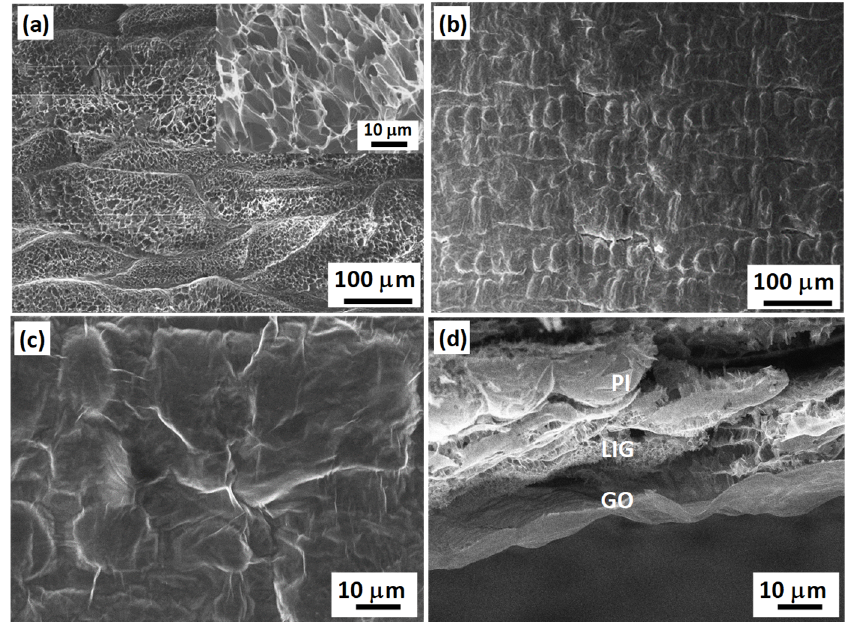
Figure 1. SEM images of ( a ) the as-fabricated LIG electrode. Inset: high magnification image of LIG; ( b ) low magnification image of the GO film deposited on the LIG electrode; ( c ) high magnification image of GO on LIG; ( d ) cross-section image showing the GO layer deposited on the LIG electrode, as well as the residual unconverted polyimide (PI)